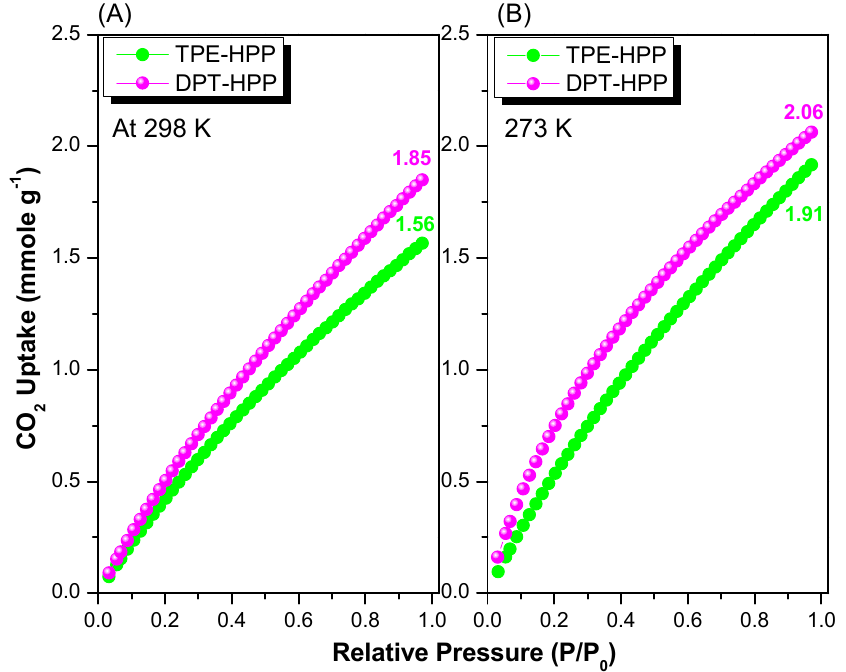
Figure 7. CO 2 uptake of TPE-HPP and DPT-HPP at ( A ) 298 K and ( B ) 273 K.